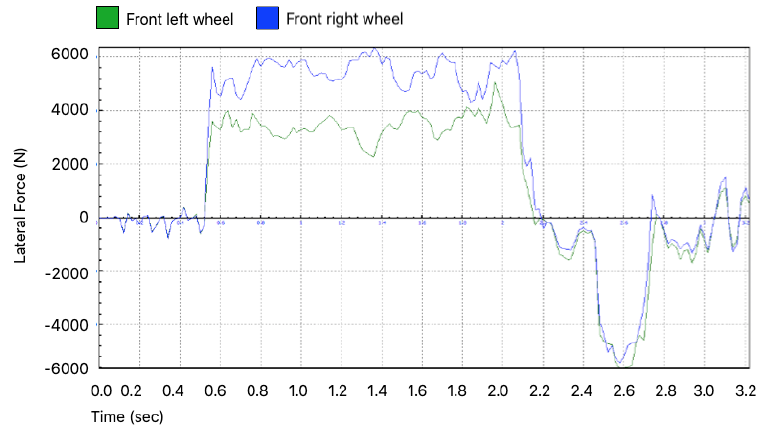
Figure 11. Resistance to total friction in the two front wheels of the bogie in a conventional turnout.